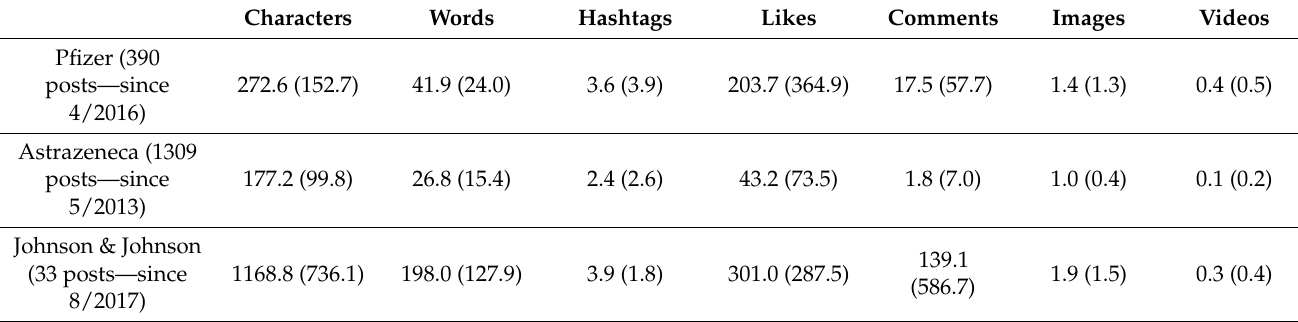
Table 3. Mean and standard deviation (in parentheses) values for the three